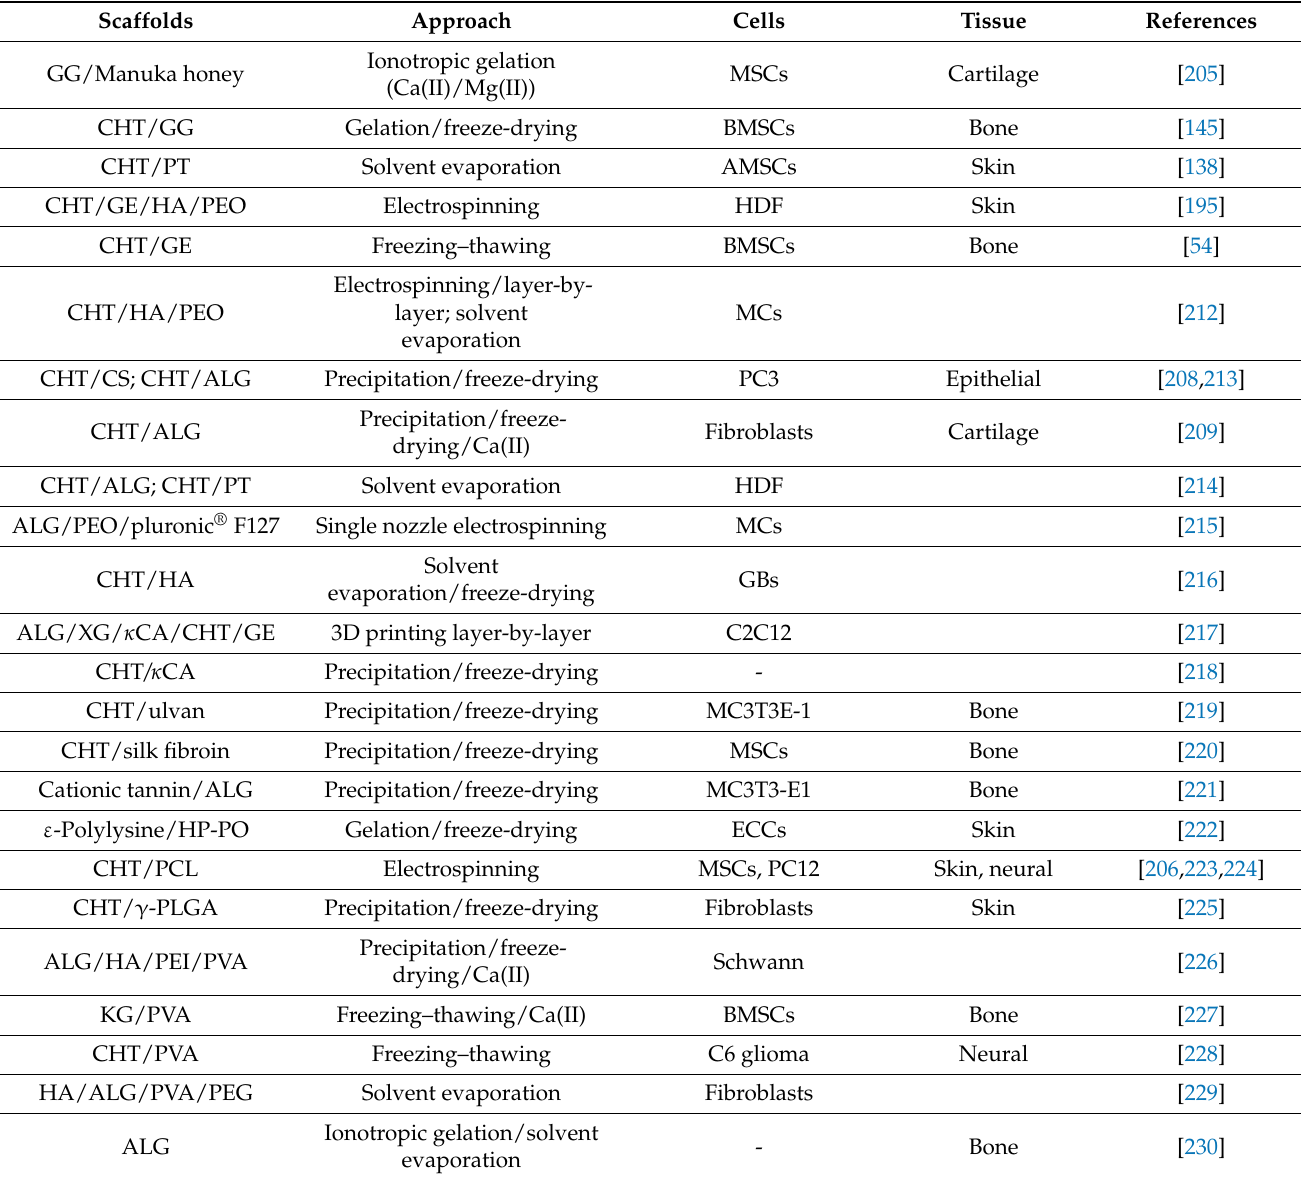
Table 1. Physical assemblies (scaffolds) based on